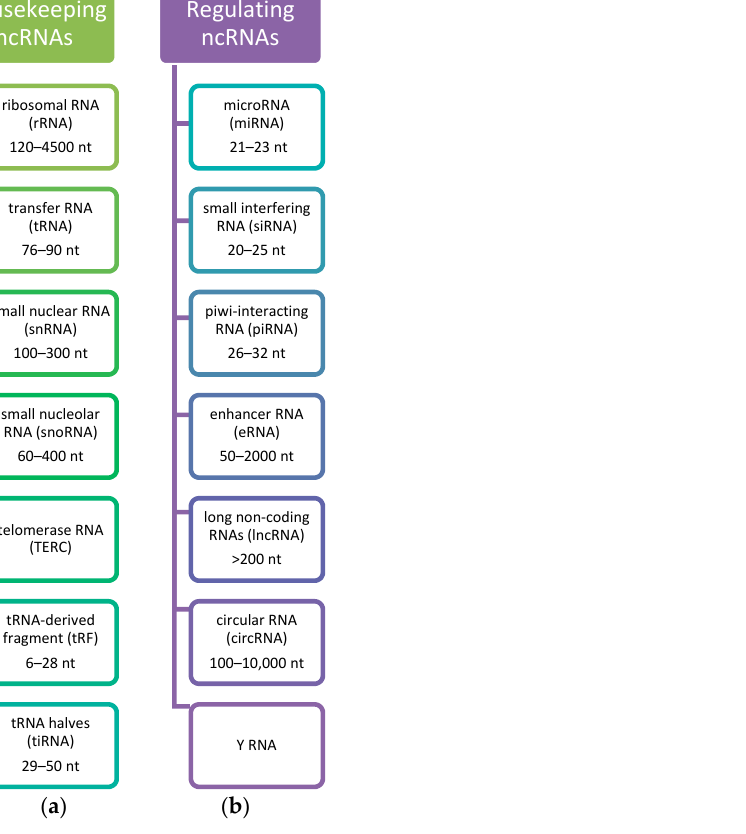
Figure 1. Classification of ncRNAs. Considering the role of ncRNAs, they are divided into ( a ) House- keeping ncRNAs that are expressed in cells, mainly regulate cellular functions and ( b ) Regulatory ncRNAs considered as regulators of gene expression at transcriptional, post-transcriptional, and epigenetic levels [49,56,58]. Based on the [49].